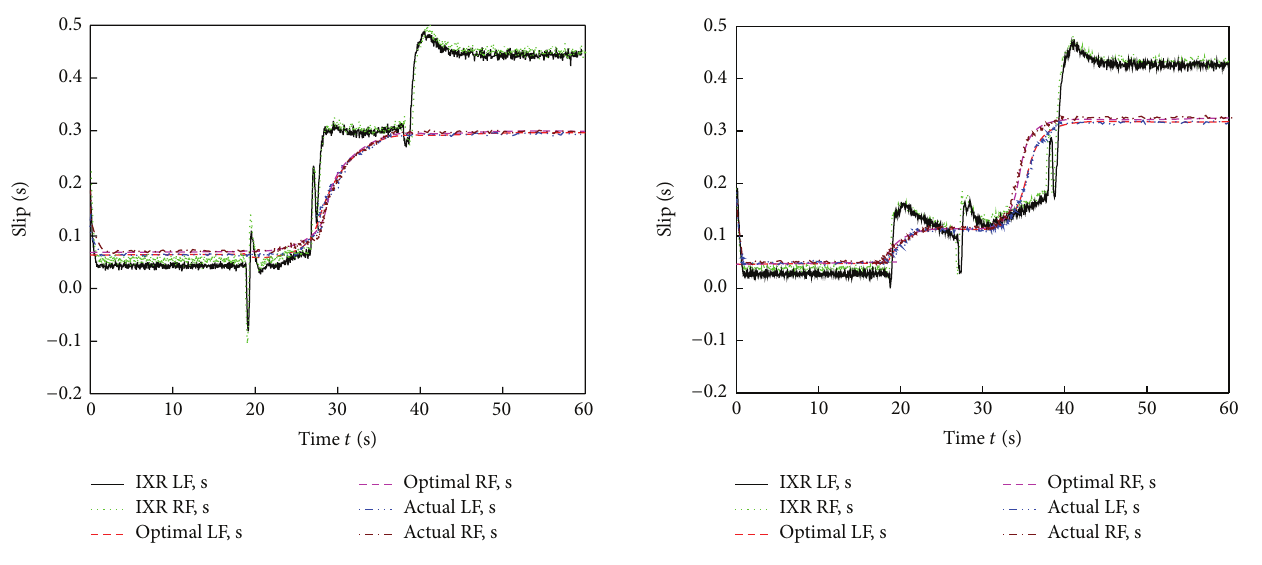
Figure 10: Front-wheels slip ratio comparison of different control strategy.